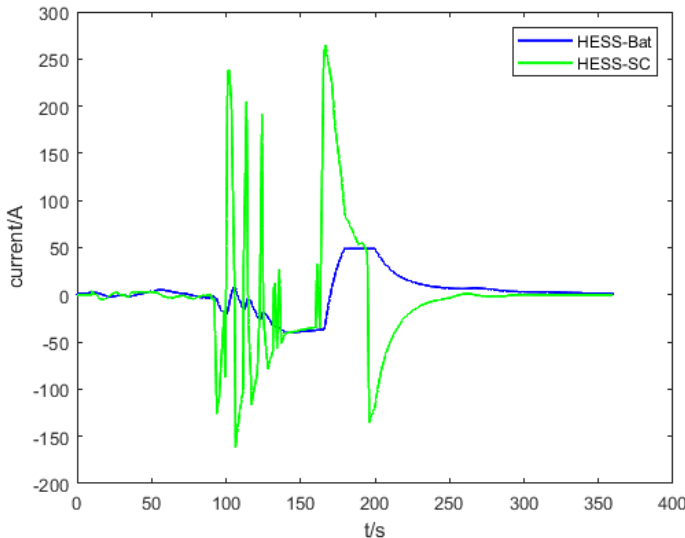
Figure 8. Battery current simulation comparison.